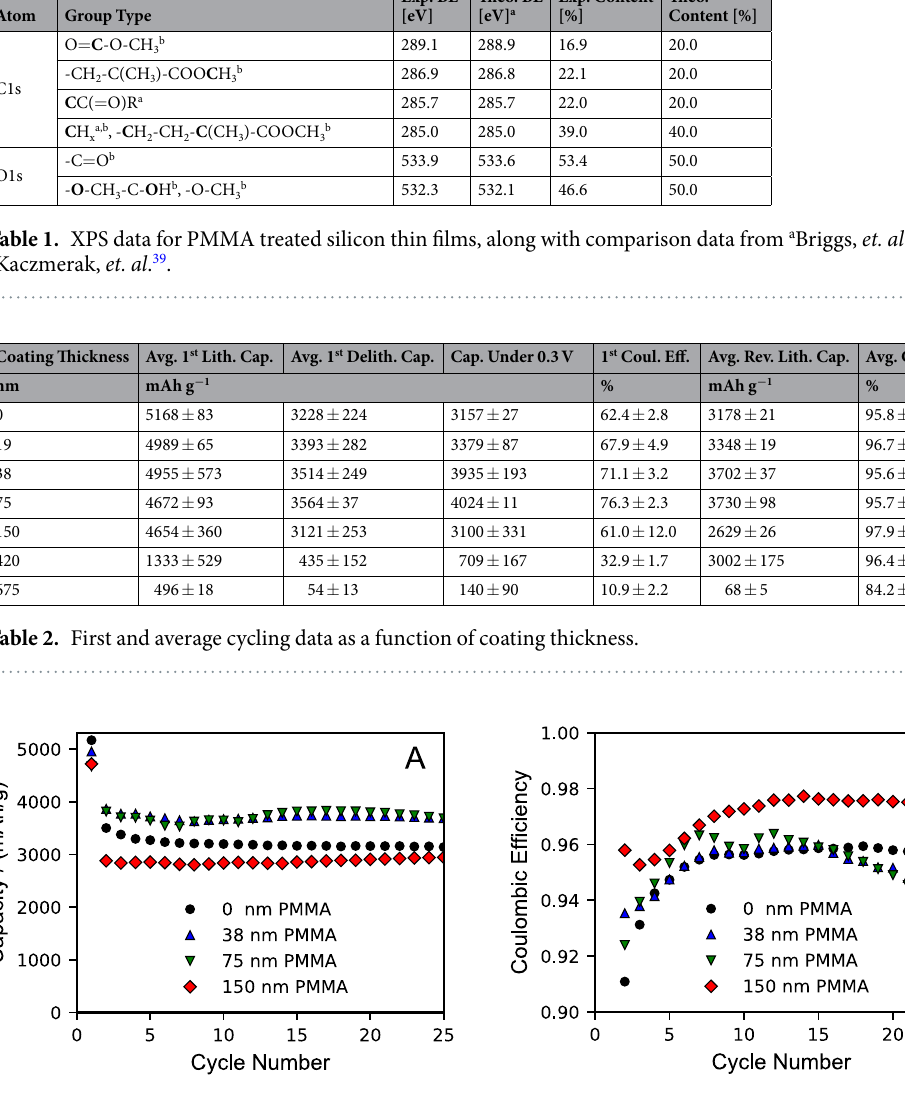
Figure 3. ( A ) Lithiation capacity and ( B ) coulombic efficiency (excluding first cycle) for silicon thin films with various coating thicknesses. Silicon electrodes were cycled against lithium metal using 1.0 M LiPF 6 in 3:7 EC/ DMC electrolyte at a (dis)charge rate of C/3 from 0.05 V to 1.5 V at room temperature.